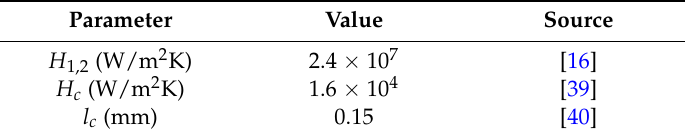
Table 2. Microstructural data for the